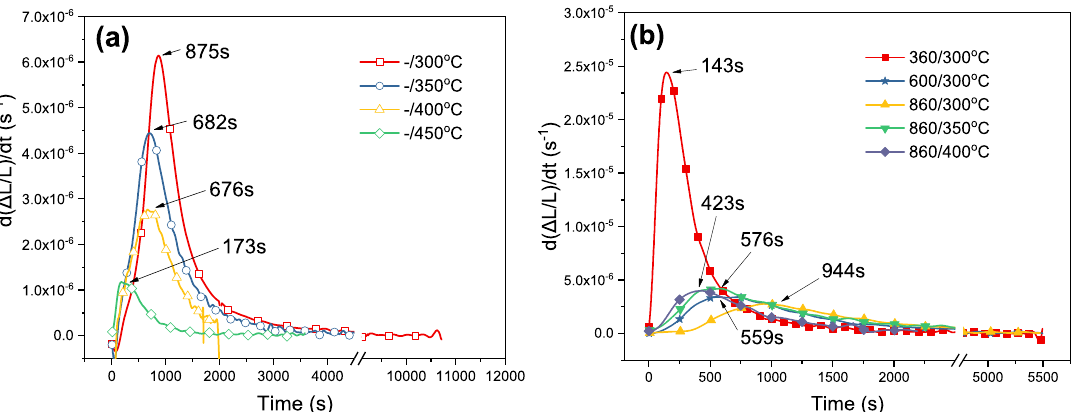
Figure 3. Transformation rate as a function of holding time in the condition of ( a ) undeformed and ( b ) deformed at different temperature followed by isothermal transformation.